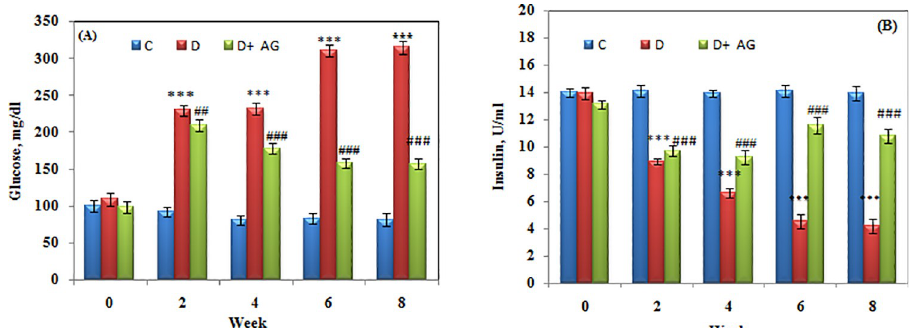
Fig 1. Glucose ( A ) and insulin levels ( B ) of alloxan-induced diabetic rabbits treated for 8 weeks with aminoguanidine. C = Control; D = Diabetic; AG = aminoguanidine. Values are mean ± SD, (n = 6 rabbits/group). ��� Significant difference (p < 0.0001) as compare to control. ### Significant difference (p < 0.0001) as compare to diabetic rats.